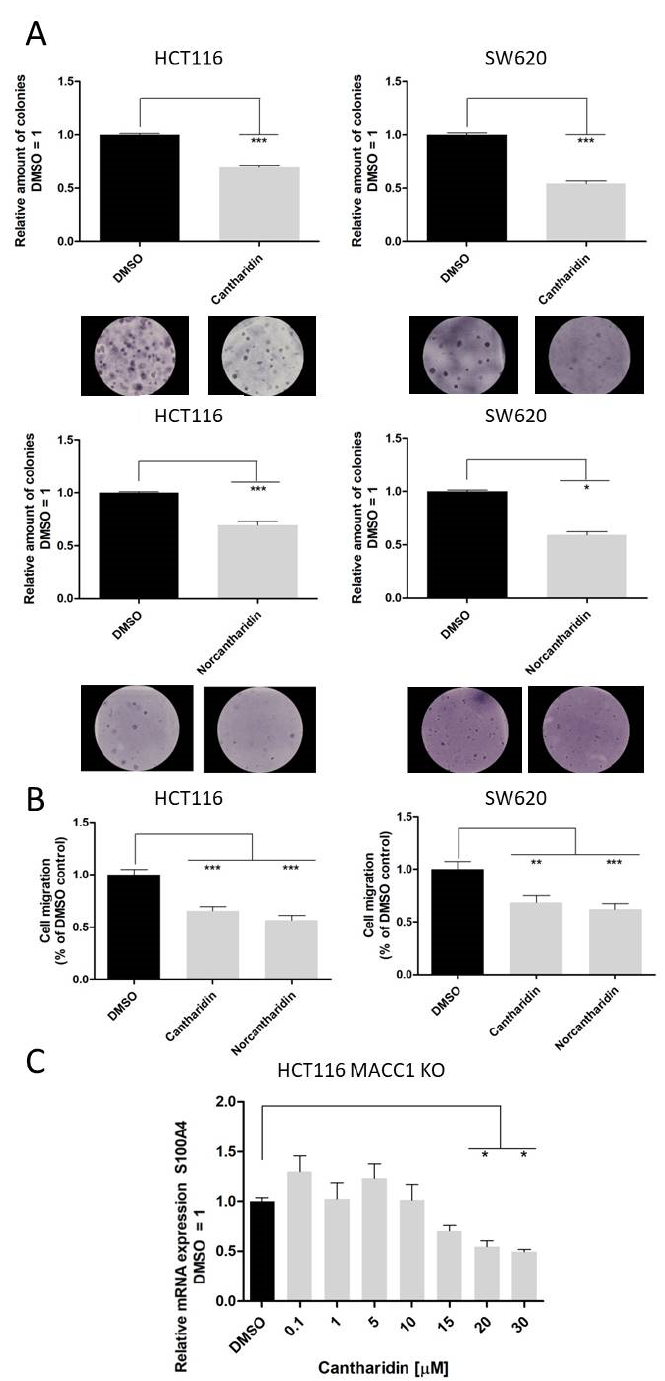
taken over a time course of 60 h. RNA was extracted and RT-qPCR was conducted for S100A4, MACC1, and the control genes GAPDH and RPII. The black bar indicates the starting point at 0 h and the grey bars indicate each timepoint after 0h. The data represent mean ± SEM ( n = 3), * p < 0.05, ** p < 0.01, *** p < 0.001. ( A ) Time dependent inhibition of S100A4 gene ( top ) and MACC1 gene ( bottom ) expression after treatment of HCT116 ( left ) and SW620 cells ( right ) with 10 µ M of cantharidin. ( B ) Time-dependent inhibition of S100A4 gene ( top ) and MACC1 gene ( bottom ) after treatment of HCT116 ( left ) and SW620 cells ( right ) with 10 µ M of norcantharidin.